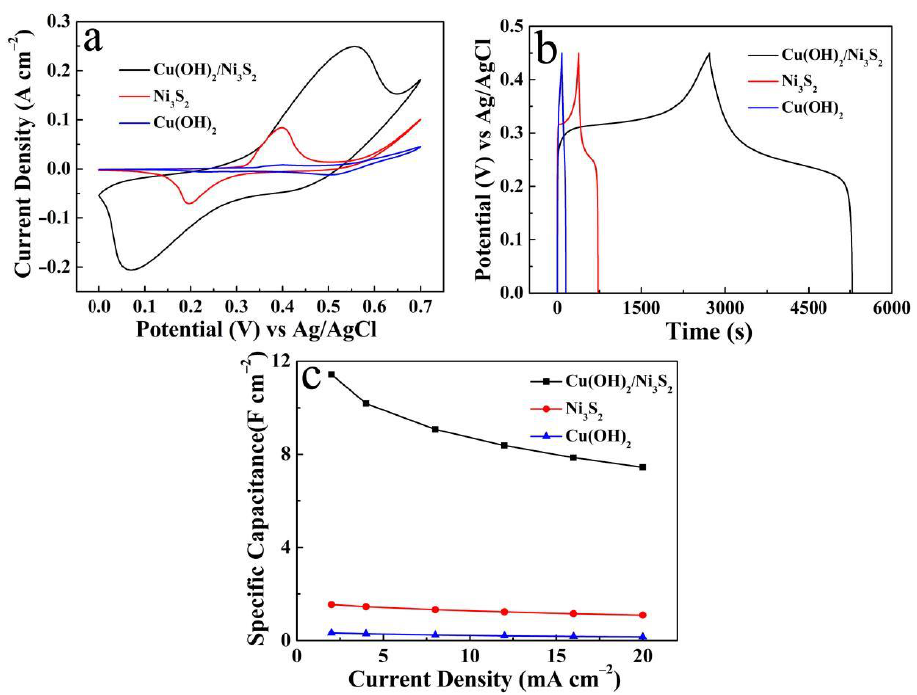
Figure 5. ( a ) CV curves at 10 mV s − 1 ; ( b ) GCD curves and ( c ) specific capacitance at different current densities of the Cu(OH) 2 /Ni 3 S 2 , Ni 3 S 2 , and Cu(OH) 2 electrode.